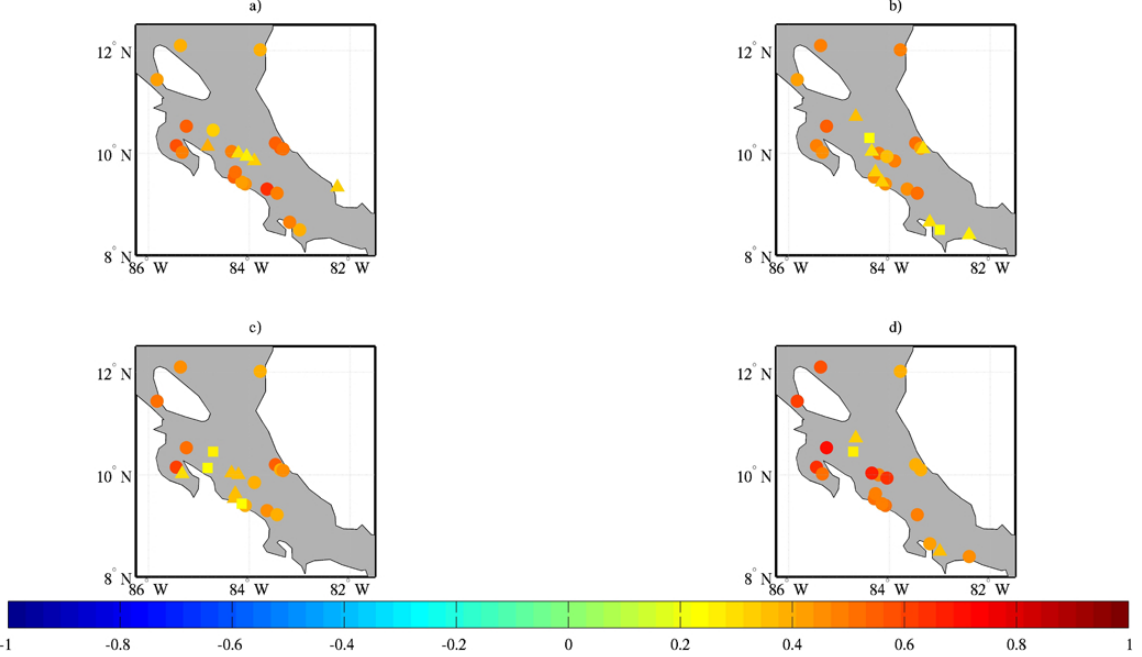
Fig. 3. Spatial skill distribution ( R ) for (a) ACM, (b) FRD, (c) P80, (d) P10 in Costa Rica for the ASO prediction using July SST field as predictor. This skill was calculated as the correlation between the observed time series and those predicted by the model using cross validation (1-month window length from 1969 to 2008). Statistical significance is between 90–95% (triangles, 5 <α < 10%), 95–99% (squares, 1 <α < 5%) and greater than 99% (circles, α < 1%). Significance was calculated according to Davis